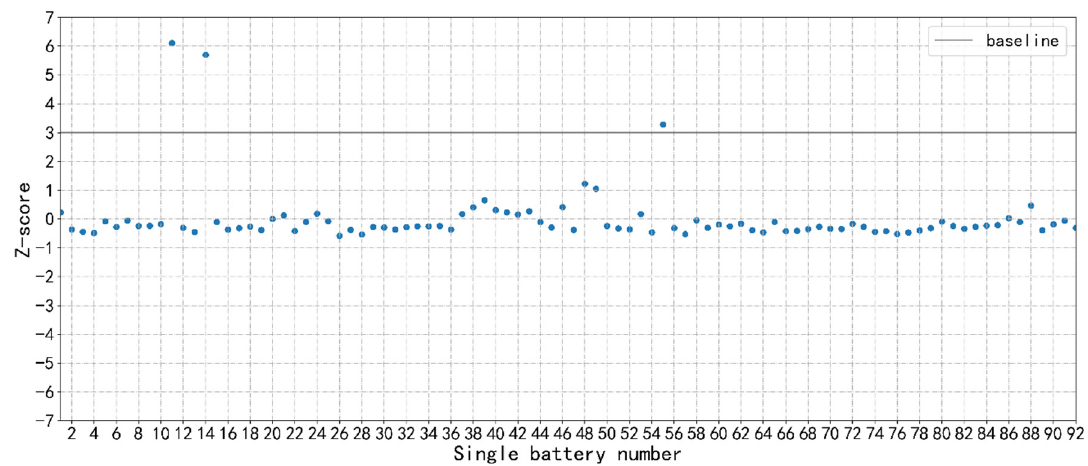
Figure 11. Scatter plot of Z-score of differential area.